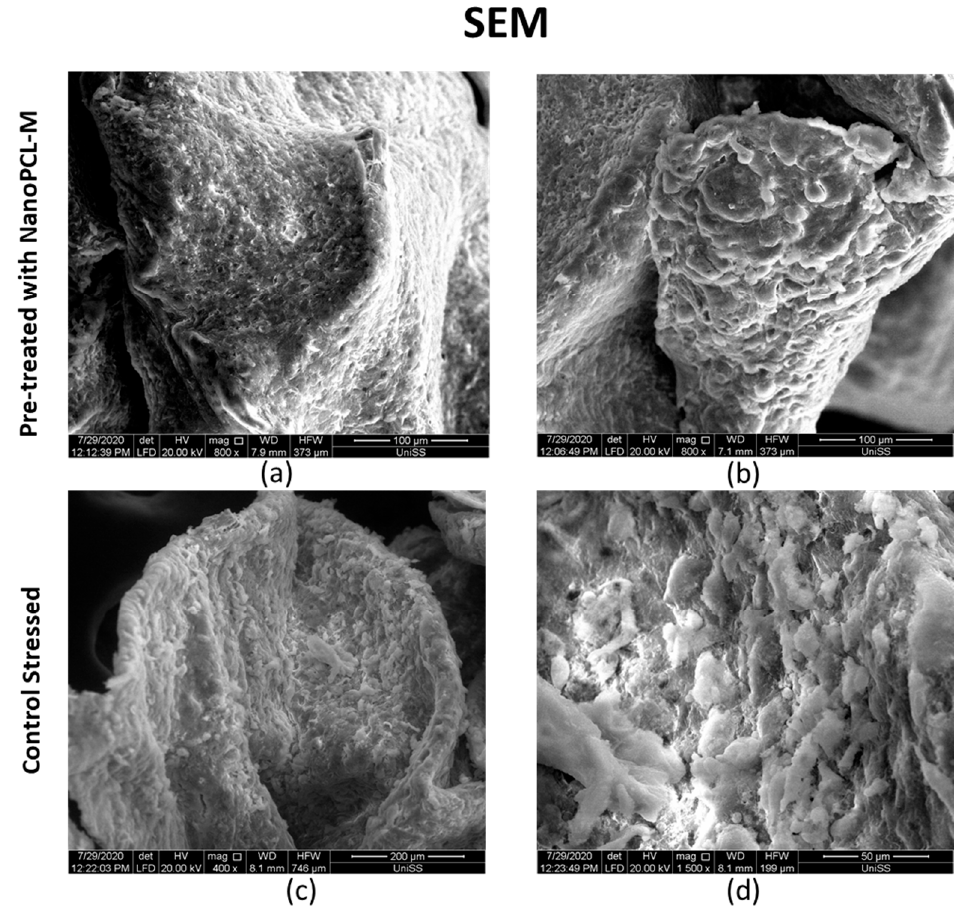
Figure 9. Images acquired with SEM microscope showing keratinocytes 3D organization. ( a ) and ( b ) represent UV stressed samples pretreated (T) with NanoPCL-M for seven days. ( c ) and ( d ) represent UV stressed samples (CS) kept in culture for seven days without any pretreatment. Scale bar is indicated in each panel.